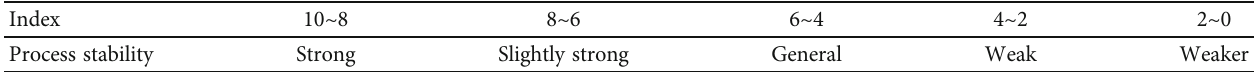
Table 2: Scoring criteria.